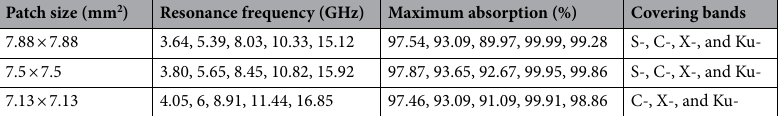
Patch size (mm 2 )